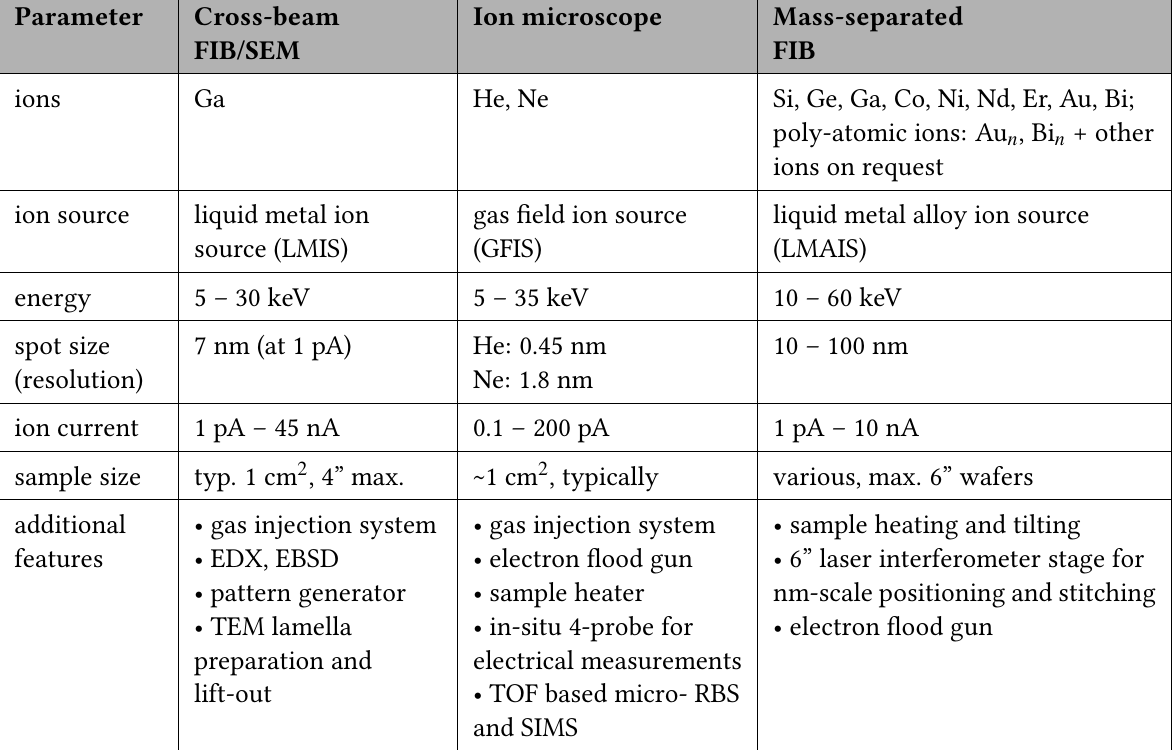
Table 5: Basic parameters of FIB systems available at